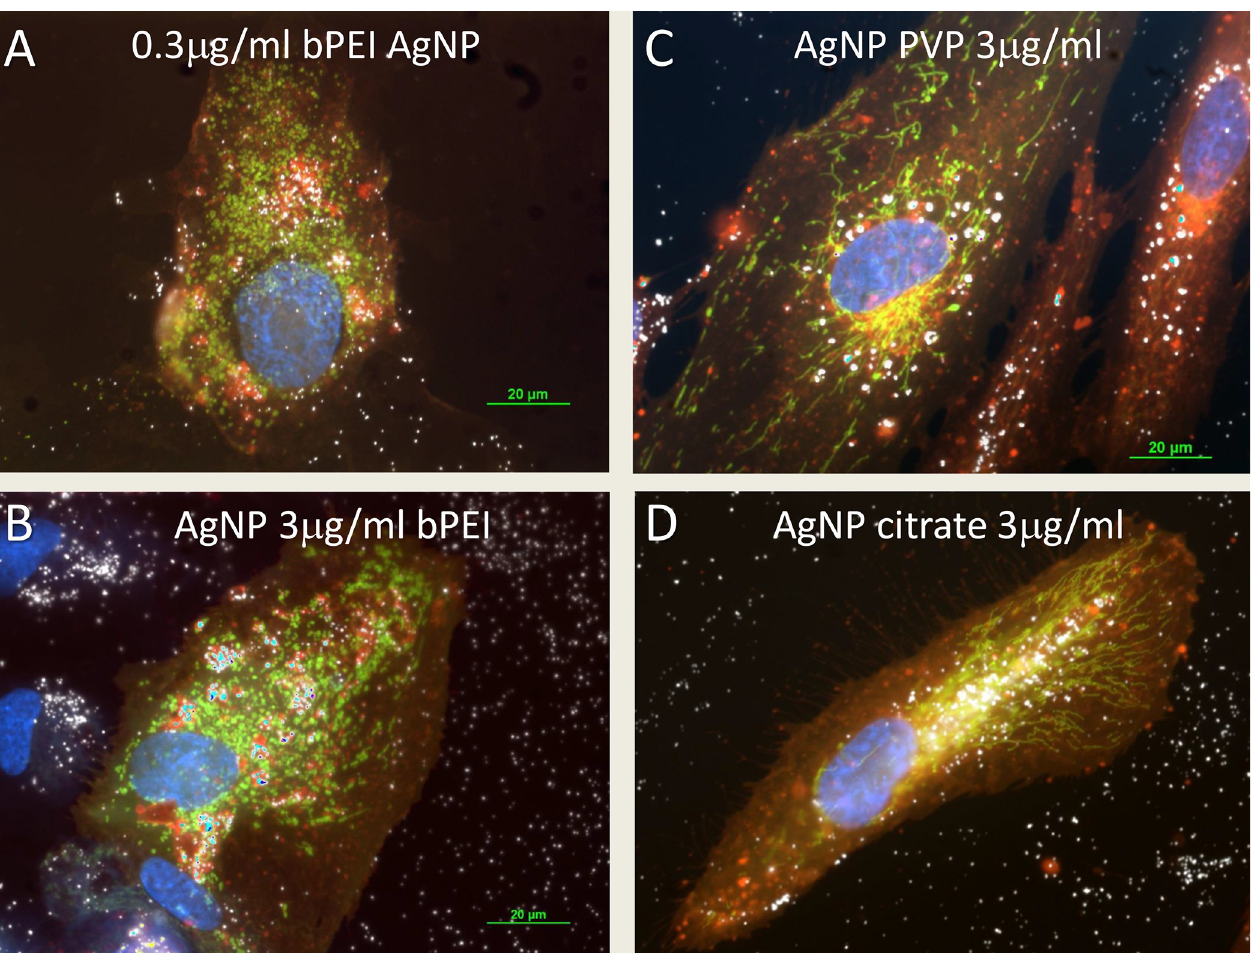
Fig 8. Microscopic comparison between different AgNP. Microscopic comparison of mitochondria after AgNP uptake into cells treated. with AgNP-bPEI, AgNP-PVP or AgNP-CIT for 24 hours. The AgNP-bPEI showed beaded structures of mitochondria at 0.3 μ g/ml (Fig 8A) and 3 μ g/ml (Fig 8B) while the AgNP-PVP 3 μ g/ml, (Fig 8C) and AgNP-CIT 3 μ g/ml,(Fig 8D) showed an elongated formation of mitochondria (designated by green color). The NP (designated by white color) are accumulated into the lysosomes (designated by red color) with the AgNP-bPEI samples while the NP are accumulated around the nuclei (Fig 8C) or in the ER (Fig 8D) with the other AgNP coated samples. The cytoplasm was stained with cell mask orange (red) and the nuclei are stained with DAPI (blue). Magnification 600x.